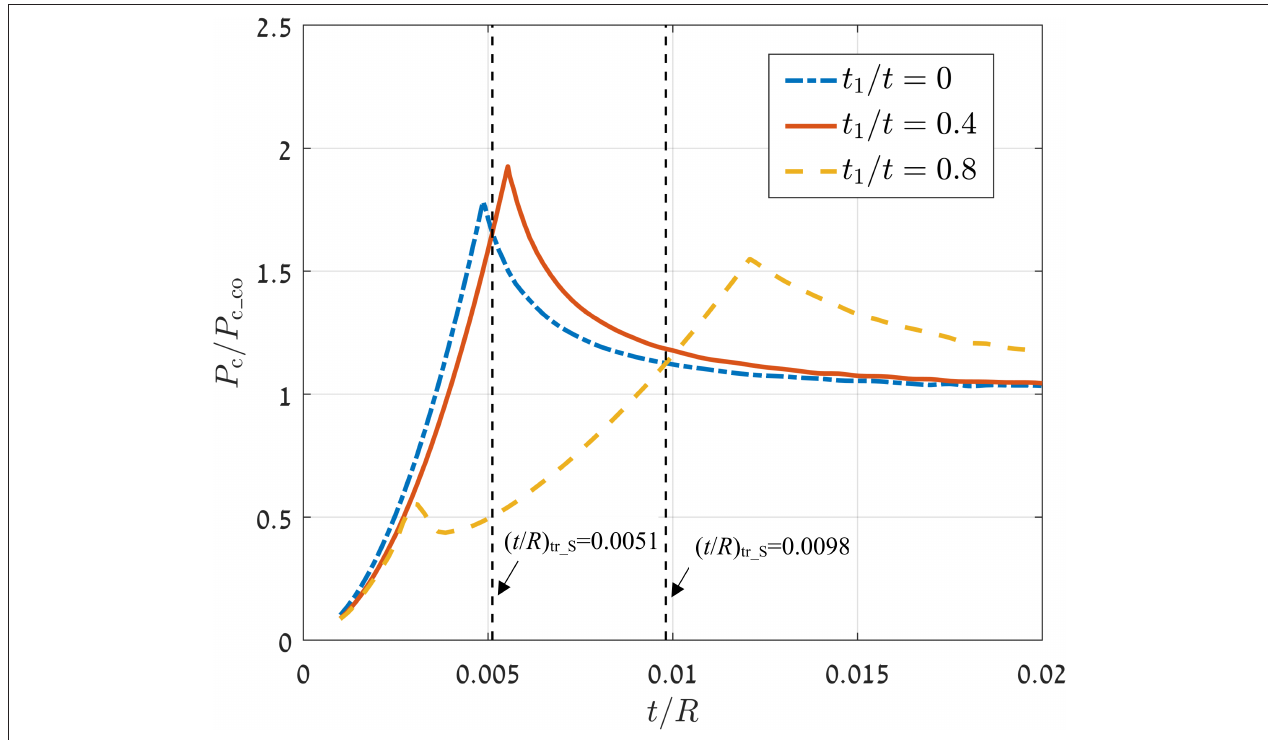
FIGURE 4 | Dimensionless critical load, P c / P c_co , vs. dimensionless coating thickness, t / R , for bilayer coated spheres. Material properties as in Table 1